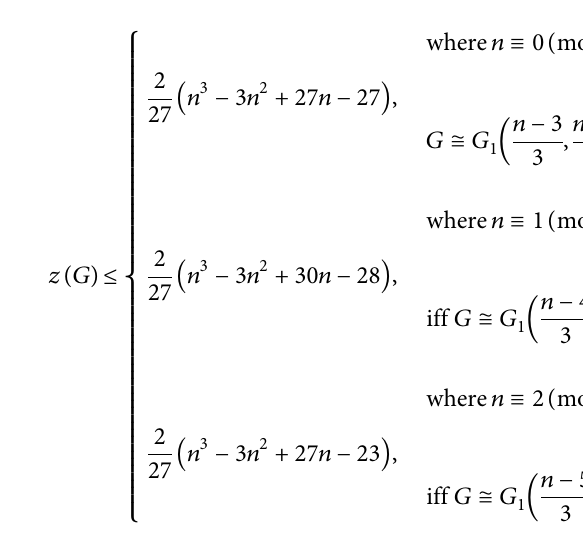
, i � 1 , 2 , . .. , 14, with diameter of i